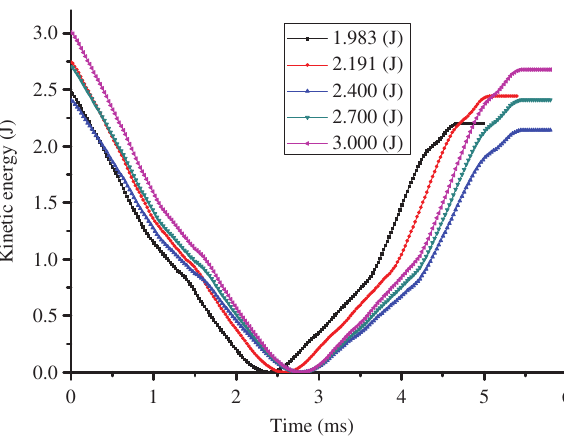
Table 6: The damaged area of the adhesive layer and the